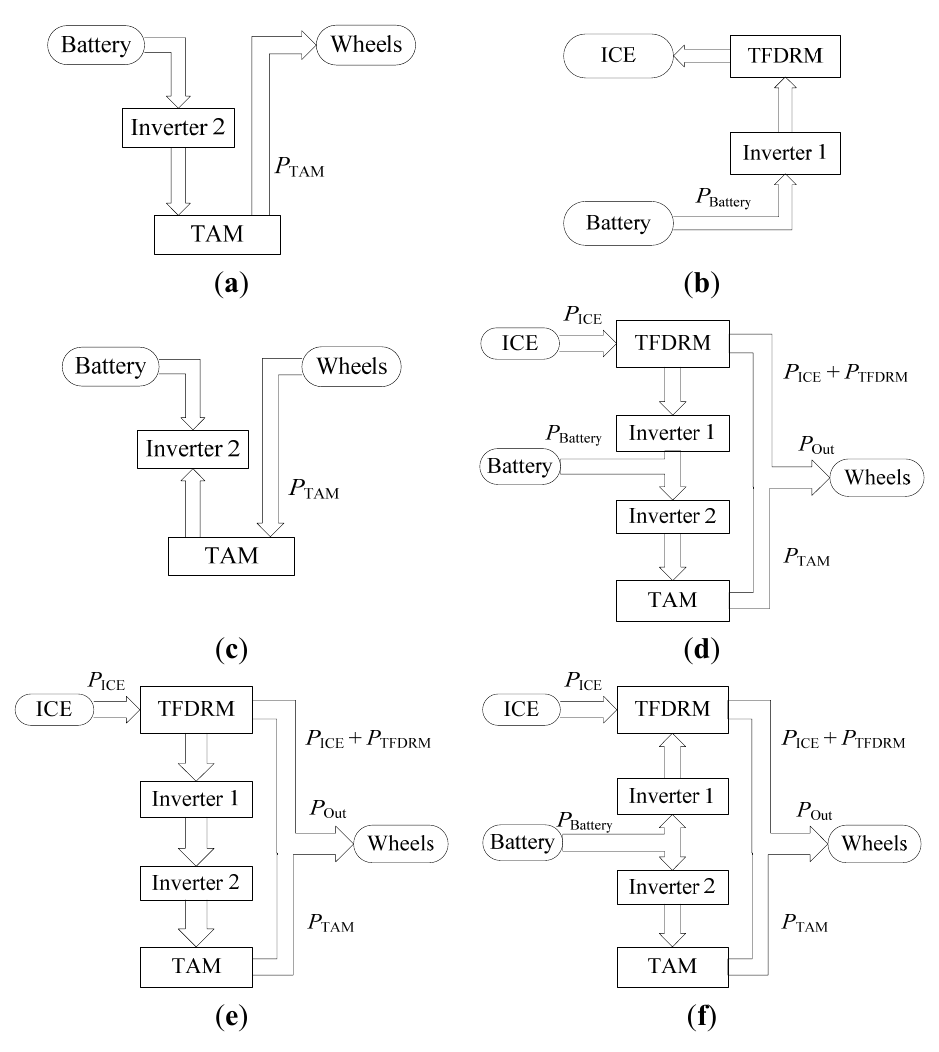
Figure 3. Typical operation states of the power-split hybrid drive system: ( a ) Pure electric mode; ( b ) ICE starter mode; ( c ) braking mode; ( d ) hill climbing mode; ( e ) CVT mode; ( f ) acceleration